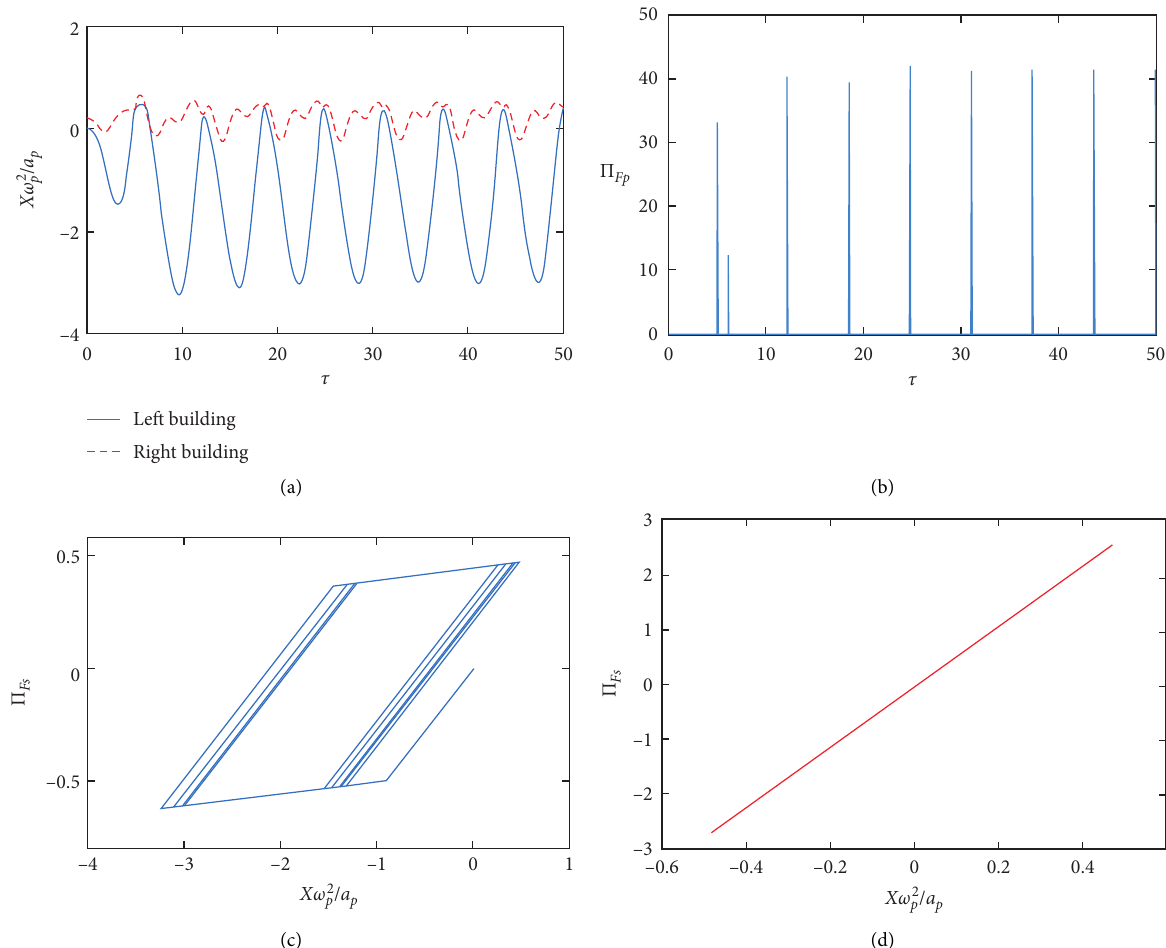
Figure 3: Time-histories and force-drift loops of two inelastic SDOF structures with parameter set 1. (a) Displacement histories. (b) Pounding force histories. (c) The story shear force-drift loop for left-side structure. (d) The story shear force-drift loop for right-side